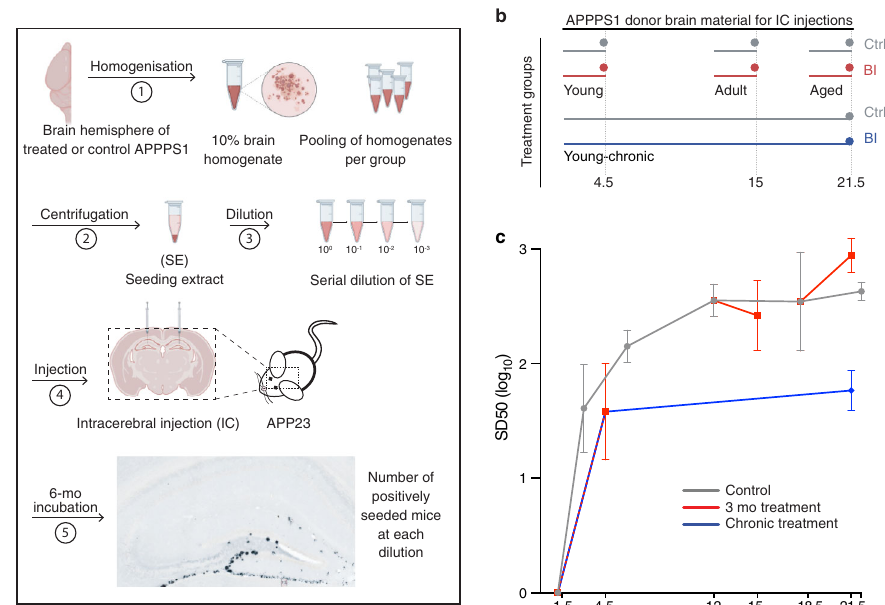
Fig. 3 | Brain A β seeding activity after short-term and chronic BACE1 inhibi- tion.a Brainextractsfromallmicewithinagroupwerepooled,seriallydiluted,and intracerebrally (IC) injected into the hippocampus of young, pre-depositing 2- to 3-mo old female APP23 host mice ( n =4 – 6 per extract; for exact numbers see Supplementary Fig. 1b). APP23 host mice were analyzed for A β deposition